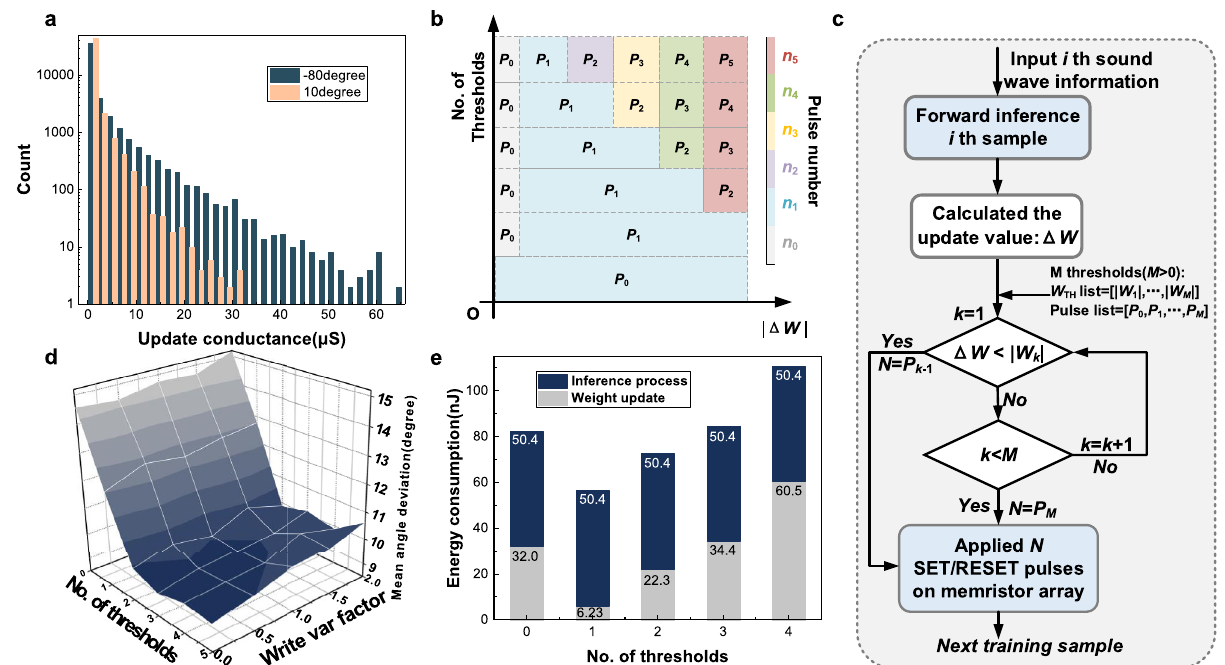
Fig. 3 Schematic diagram and simulation results of various training schemes. a The distributions of update values of samples corresponding to various angles. b Schematic diagram of the multi-threshold-update scheme. As the updating levels increase, there will be more thresholds for Δ W classi fi cation to apply different numbers of pulses on the memristor device. c Flow chart of in situ training with the multi-threshold-update scheme. d Simulation results under various update levels and variation factors. The factor scales the updating variation of the devices. e The total energy consumption of memristor- based sound localization under various number of update